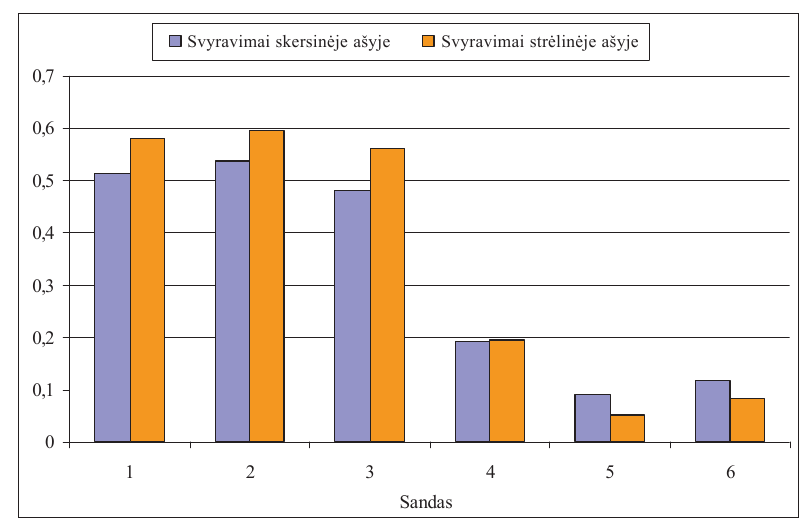
koe fi cientai (r 2 ). Ypa č didelis r 2 pastebimas aukš- tesni ų dažni ų srityje (1—3 sand ų ). Šioje srityje nustatytas stiprus koreliacinis ryšys tarp sando galios ir dvilypio blauzdos raumens standumo — r ≈ 0,6 (4 pav.). Šie duomenys patvirtina teigin į